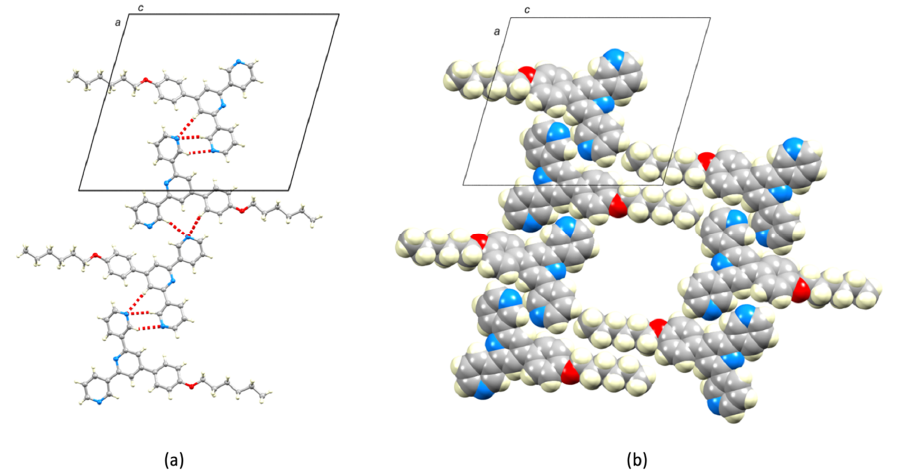
Figure 4. Molecules of 6 pack into 2D-sheets involving CH...N weak hydrogen bonds and van der Waals interactions between n -hexyloxy chains. The unit cell is viewed down the b -axis. ( a ) C–H...N hydrogen bonds and ( b ) a space-filling representation of part of one supramolecular sheet showing one void between pairs of n -hexyloxy chains.